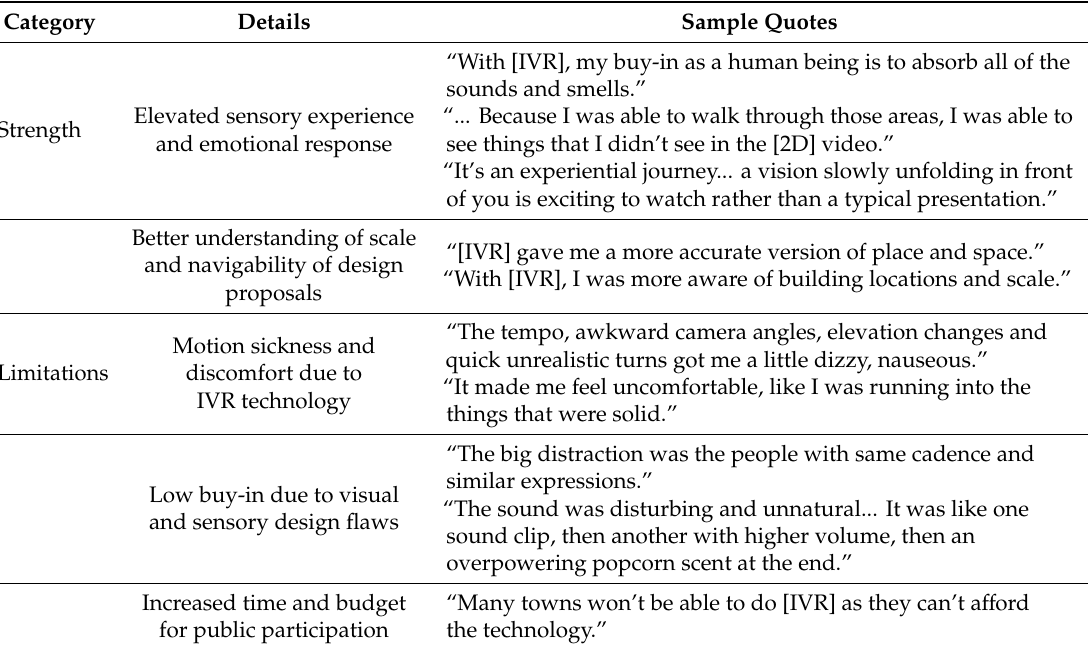
Table 5. Strengths and limitations of IVR